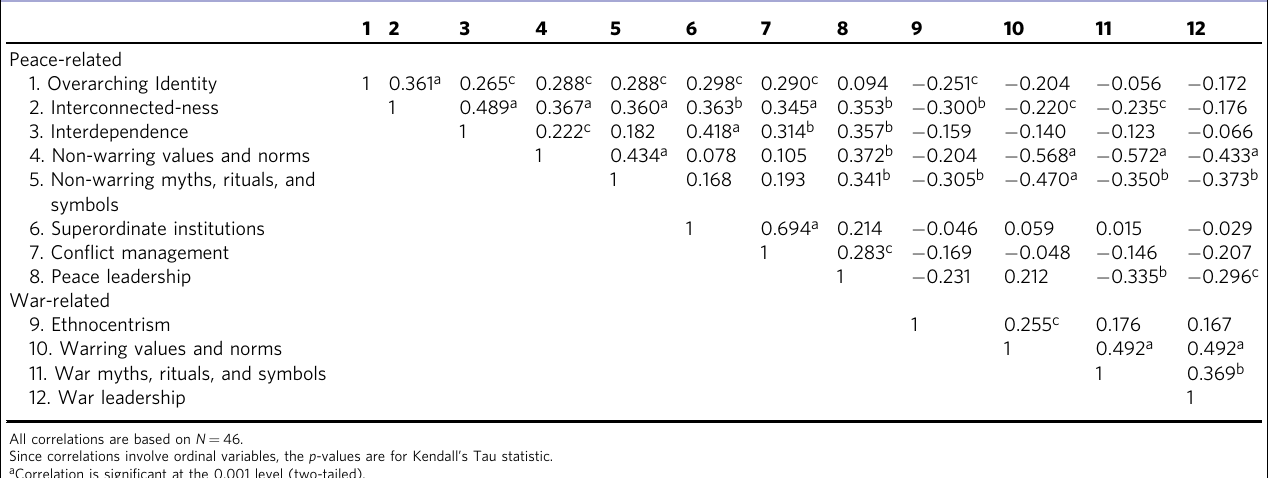
Table 1 Correlations among peace-related and war-related variables.